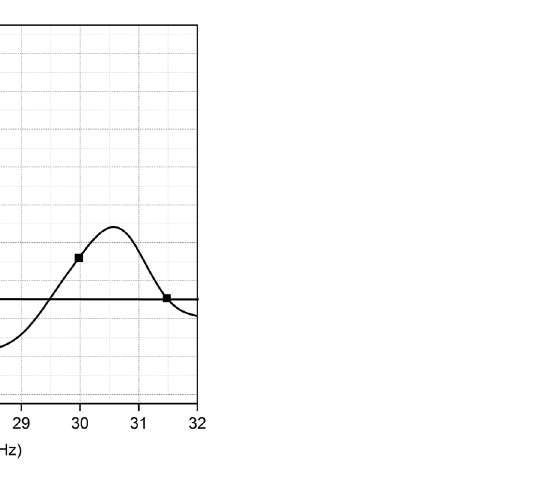
Figure 14. Envelop correlation coefficient of